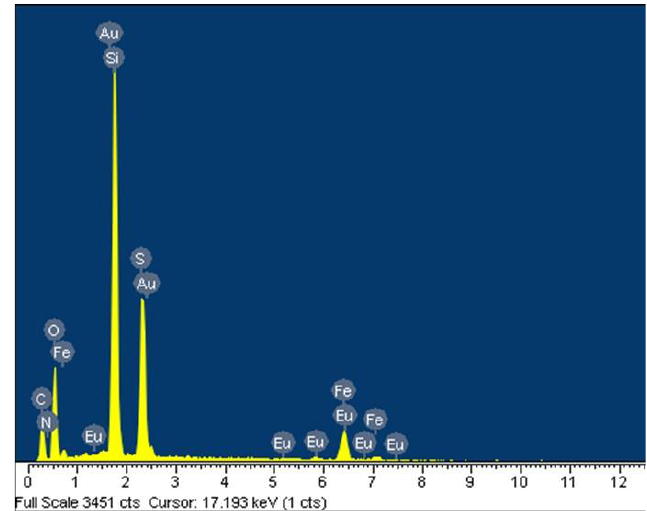
Figure 5. EDX elemental analysis of FOASET NC.